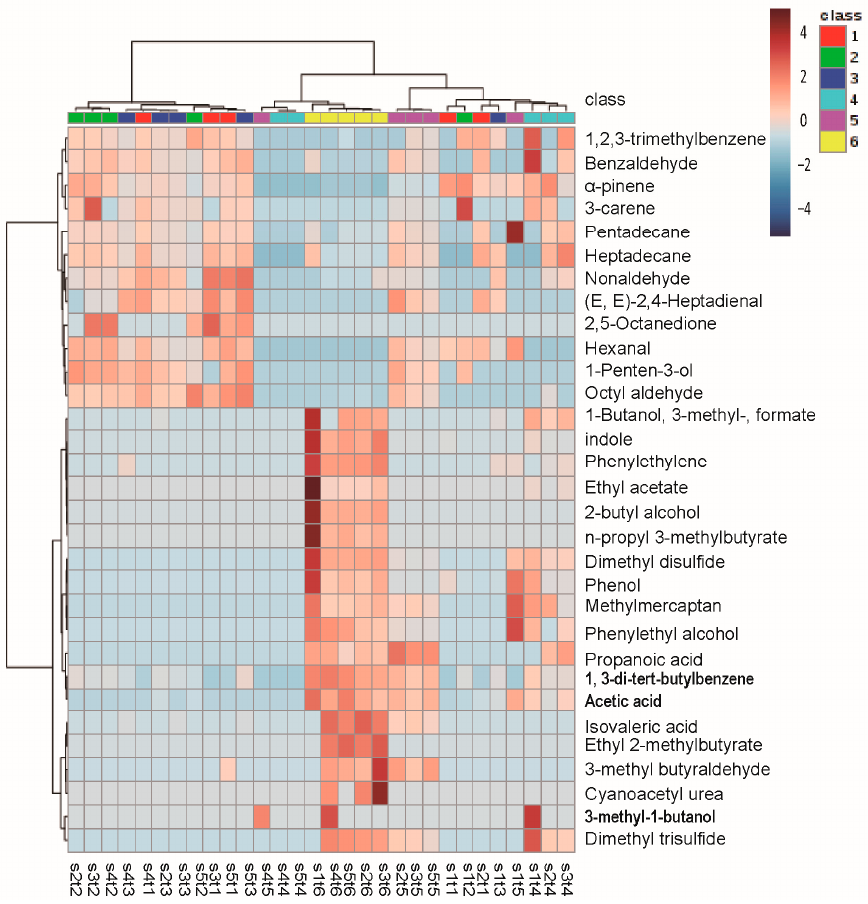
Figure 4. Clustering result shown as heatmap. Storage time at 25 °C: class 1 represents 0 h, class 2 represents 24 h, class 3 represents 36 h, class 4 represents 48 h, class 5 represents 60 h, and class 6 represents 72 h. Each experimental group is set with five parallels. The x-axis is expressed in the form of SaTb, where “a” represents the parallel value and “b” represents the class of different storage days. The most and least intense relative abundance values are depicted in red and blue, respectively.